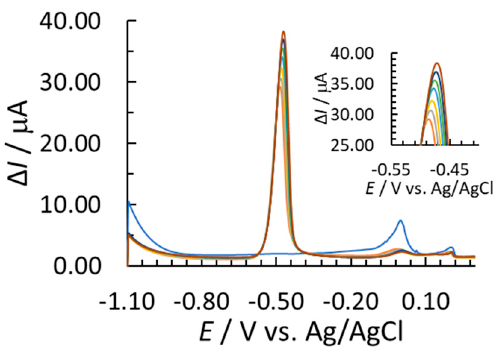
Figure 9. Voltammograms measured using SbFSPE (0.5 mg/L (Sb(III)) for the real river water sample without and with the successive addition of Pb(II) ( E acc = − 1.1 V, t acc = 60 s).